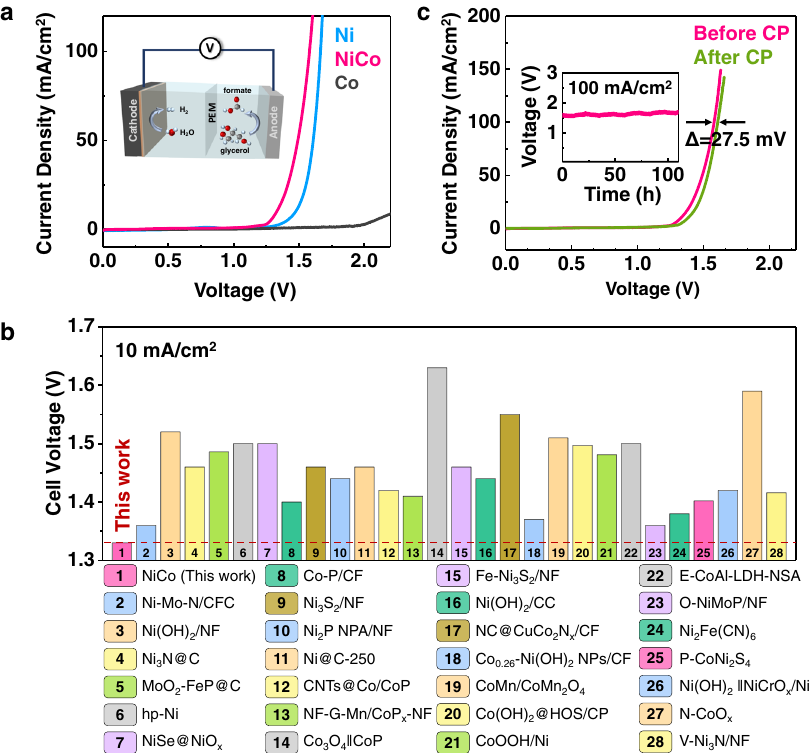
Fig. 5 Overall electrolysis performance of coupling GOR with hydrogen evolution reaction (HER). a LSV polarization curves for overall electrolysis coupling HER and GOR. The inset is the schematic illustration of the overall electrolysis con fi guration. b The comparison of overall electrolysis performance coupling organic oxidation reactions with HER in aqueous media at the current density of 10 mA/cm 2 for NiCo hydroxide and other noble-metal-free electrocatalysts in recently reported literature. c LSV polarization curves of NiCo hydroxide before and after chronopotentiometry measurement performed at 100 mA/cm 2 for 110 h. The inset is the chronopotentiometry curve of NiCo hydroxide performed at 100 mA/cm 2 for 110 samples were further immersed in 0.1M cobaltous acetate solution and heated to 80°C for 2 h to obtain NiCo hydroxide. Then the samples were washed by deio-